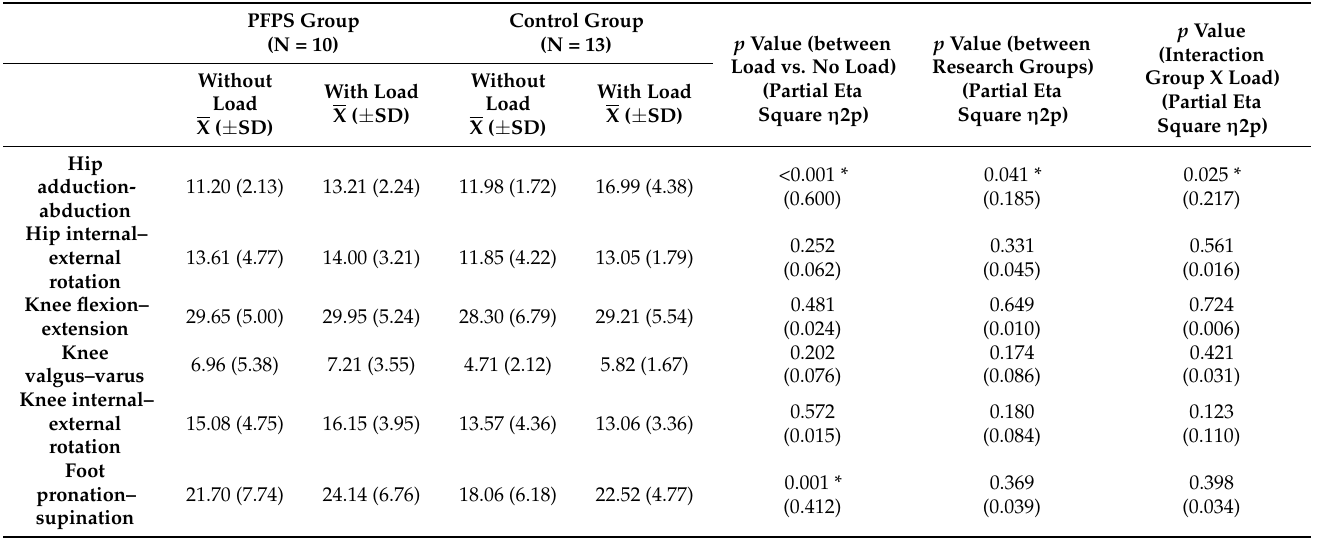
Table 3. Joint range of motion parameters with and without load according to research groups and load condition (right leg, in degrees).